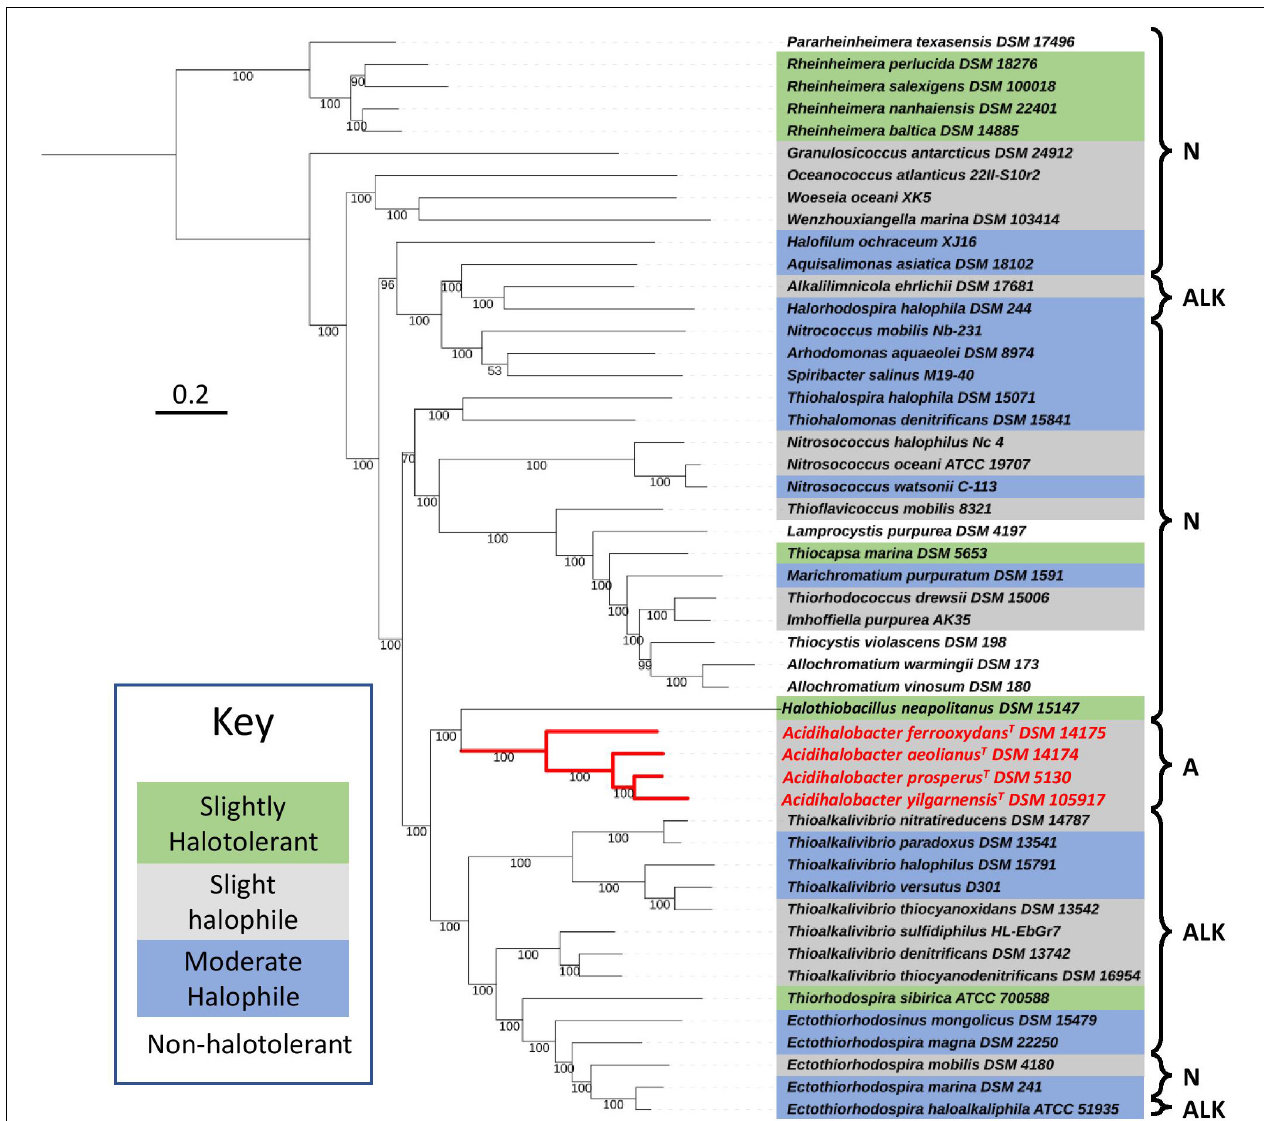
FIGURE 1 | Phylogenomic tree constructed, using 400 protein markers of 52 representative complete genomes of the Chromatiales order, using the Phylophlan3 program. Gray highlights slightly halophilic genomes (optimum growth 2–5% w/v NaCl), blue highlights moderately halophilic genomes (optimum growth 5–20% w/v NaCl), green highlights slightly halotolerant genomes (no NaCl required to grow however optimum growth in 2–8% w/v NaCl) and no highlight represents non-halophiles. A, acidophiles (optimum growth < pH 5); N, neutrophiles (optimum growth between pH 5 and 9); and ALK, alkaliphiles (optimum growth > pH 9). Red lines indicate the phylogenetic relationships between the acidophiles. The sequences were aligned with MAFFT and the concatenated alignment was used to construct the phylogenetic tree with IQTREE and LG+R3 as the best-suited evolutionary model. Scale bar indicates 0.2 substitutions per amino acid. See Supplementary Table 1 for the full information on the microorganisms used in the